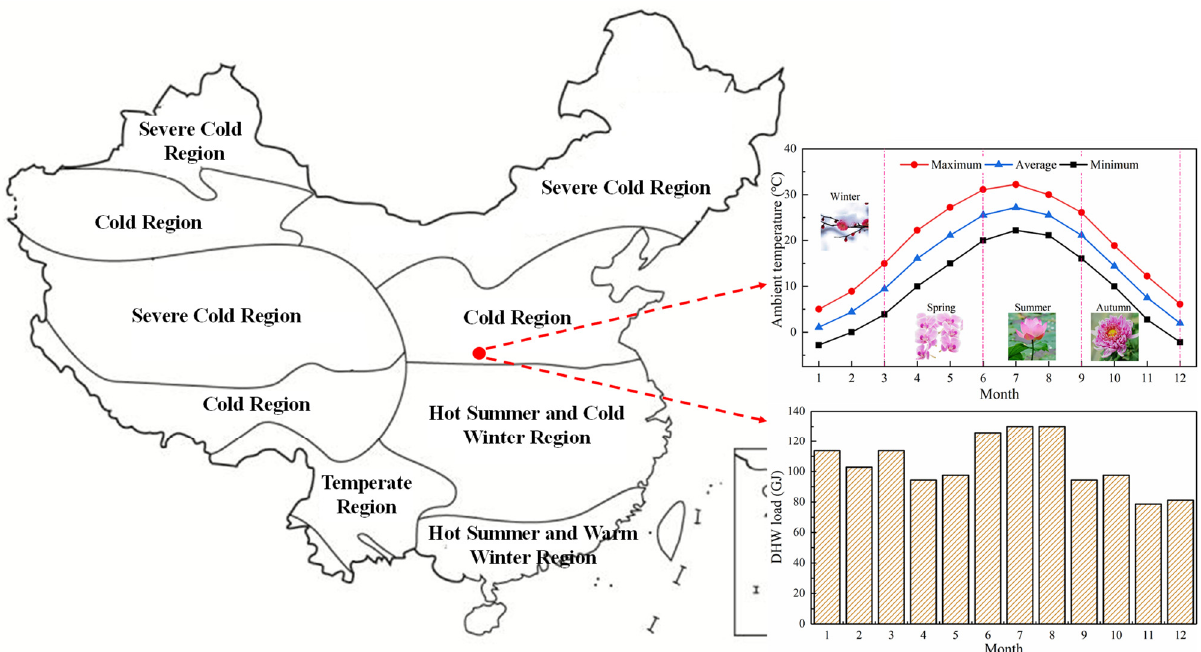
Figure 12. Location and detailed information of Xi’an city.